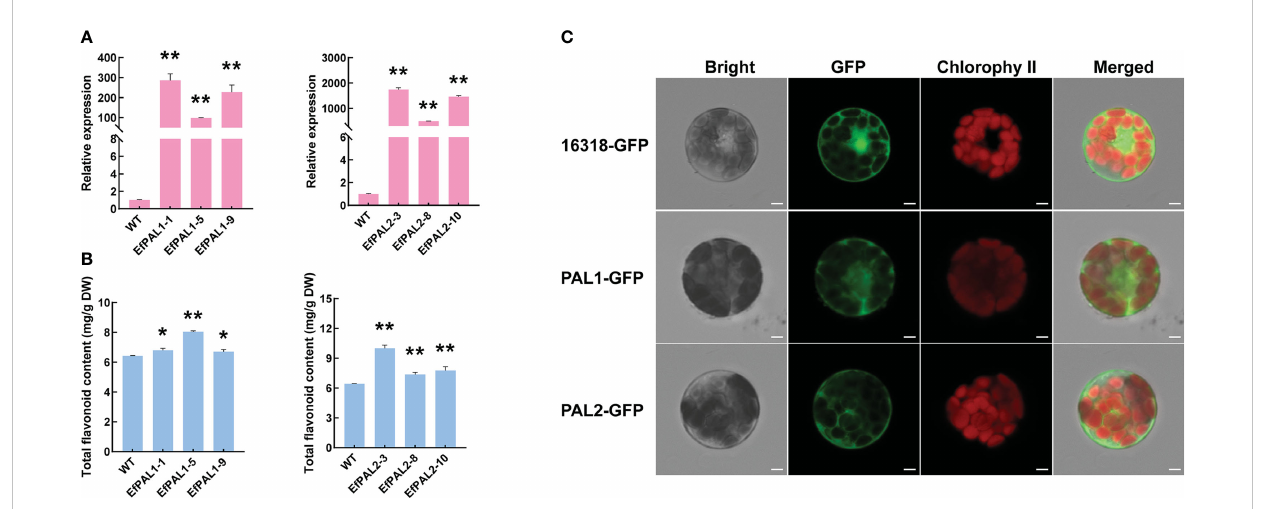
FIGURE 3 Overexpression of EfPAL1 and EfPAL2 in Arabidopsis thaliana and subcellular localization. (A) Relative expression of PAL in EfPAL1-OE lines and EfPAL2-OE lines. (B) Total fl avonoid content in leaves of Arabidopsis thaliana of EfPAL1-OE lines and EfPAL2-OE lines. (C) B, Subcellular localization of EfPAL1 and EfPAL2 in the protoplasts of Arabidopsis thaliana , Bar=25 m m. The ‘ * ’ or ‘ ** ’ above the histogram indicated the statistical signi fi cance at the level of 0.05 or 0.01(p < 0.05; p < 0.01). Error bars show SD from three biological